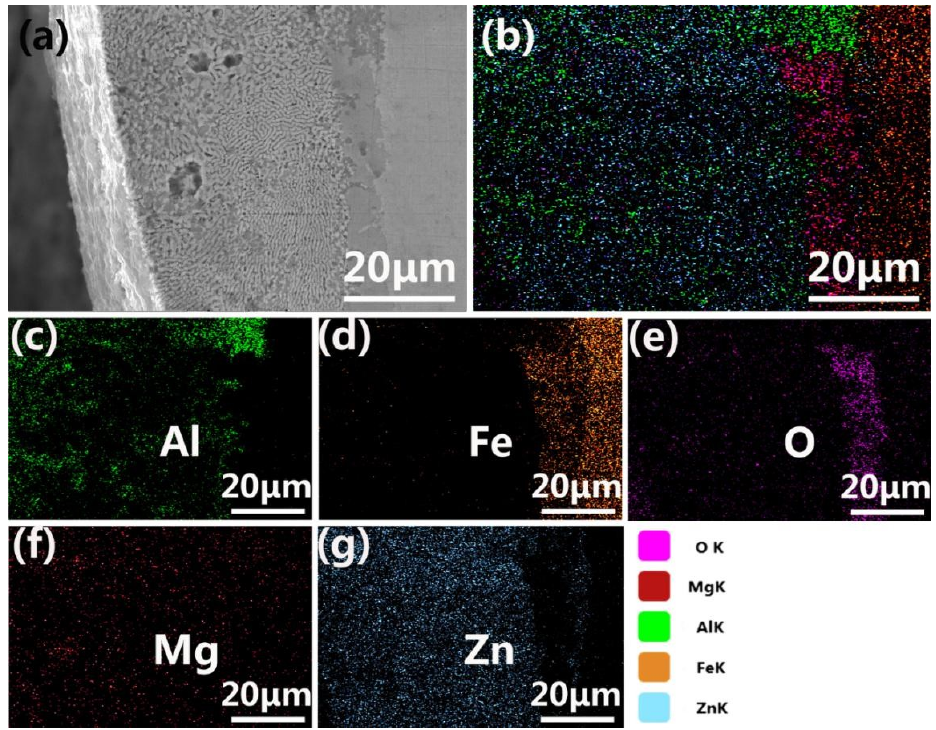
Figure 15. Element distribution of the cross section of the coating of an unpolished steel plate. ( a ) The cross-sectional morphology of the coating, ( b ) All elements, ( c ) Al, ( d ) Fe, ( e ) O, ( f ) Mg, ( g ) Zn.